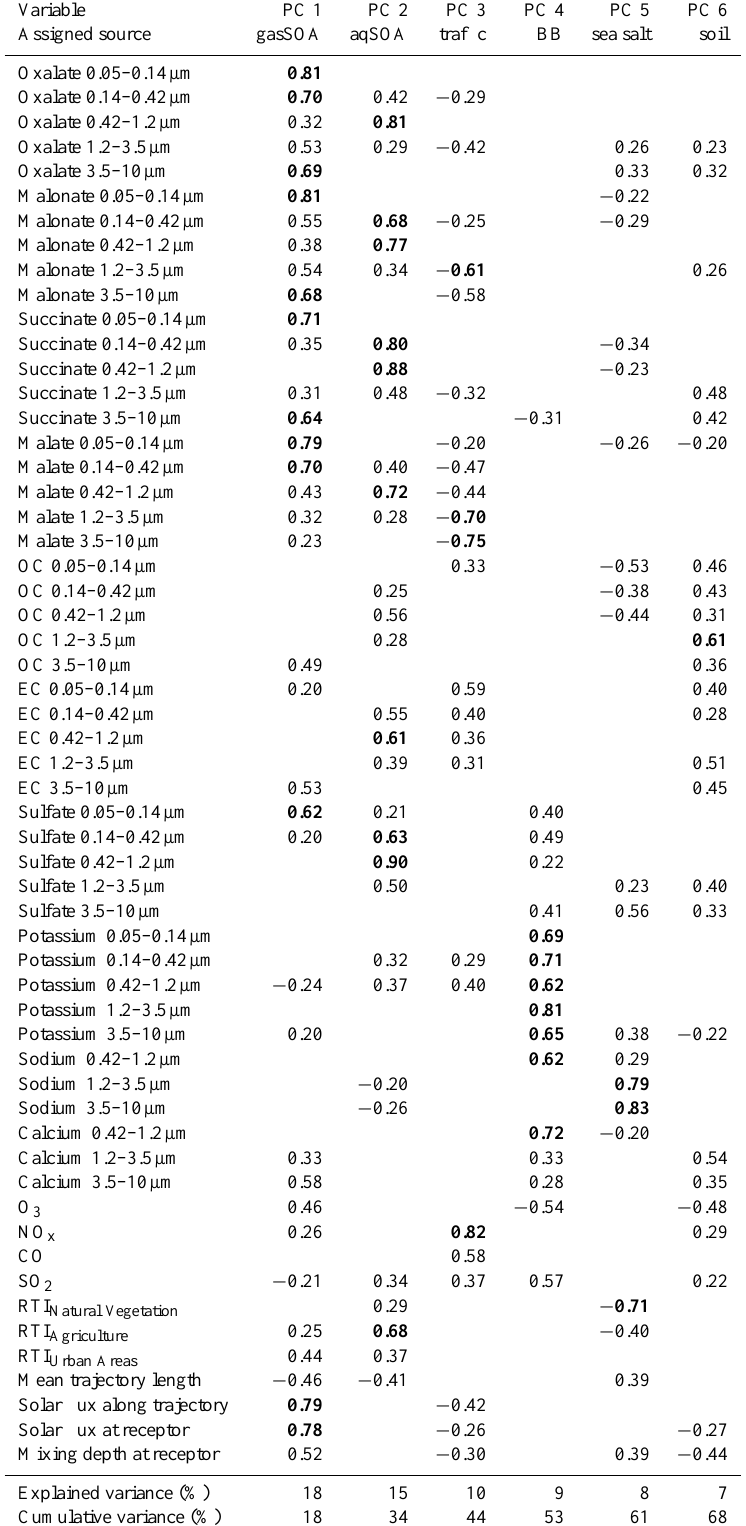
Table 2. Loadings of PCA after Varimax rotation. Loadings with | x |<0.2 are considered insignificant and removed, while loadings with | x | ≥ 0.6 are considered as “high” and are printed